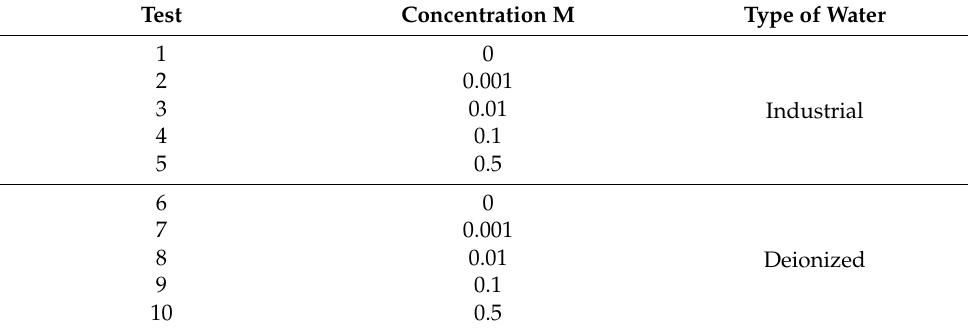
Table 5. Experimental design tests with KCl.